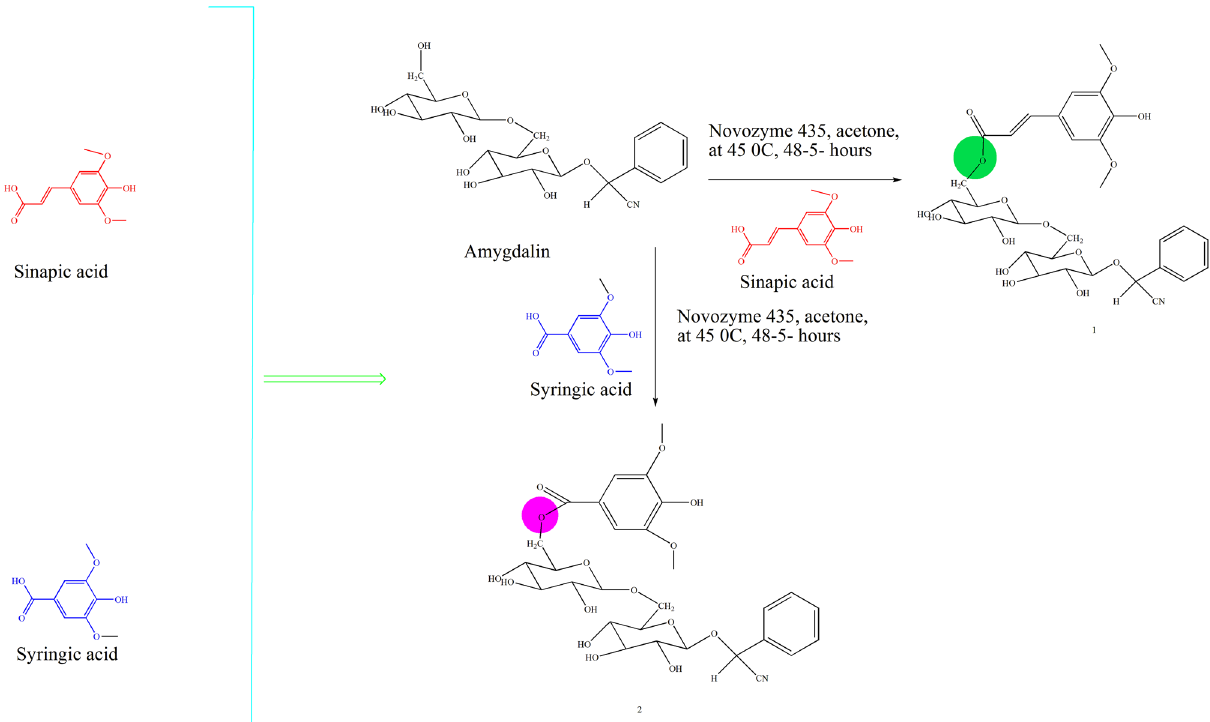
Figure 1. Design strategy and Scheme used for the synthesis of amygdalin